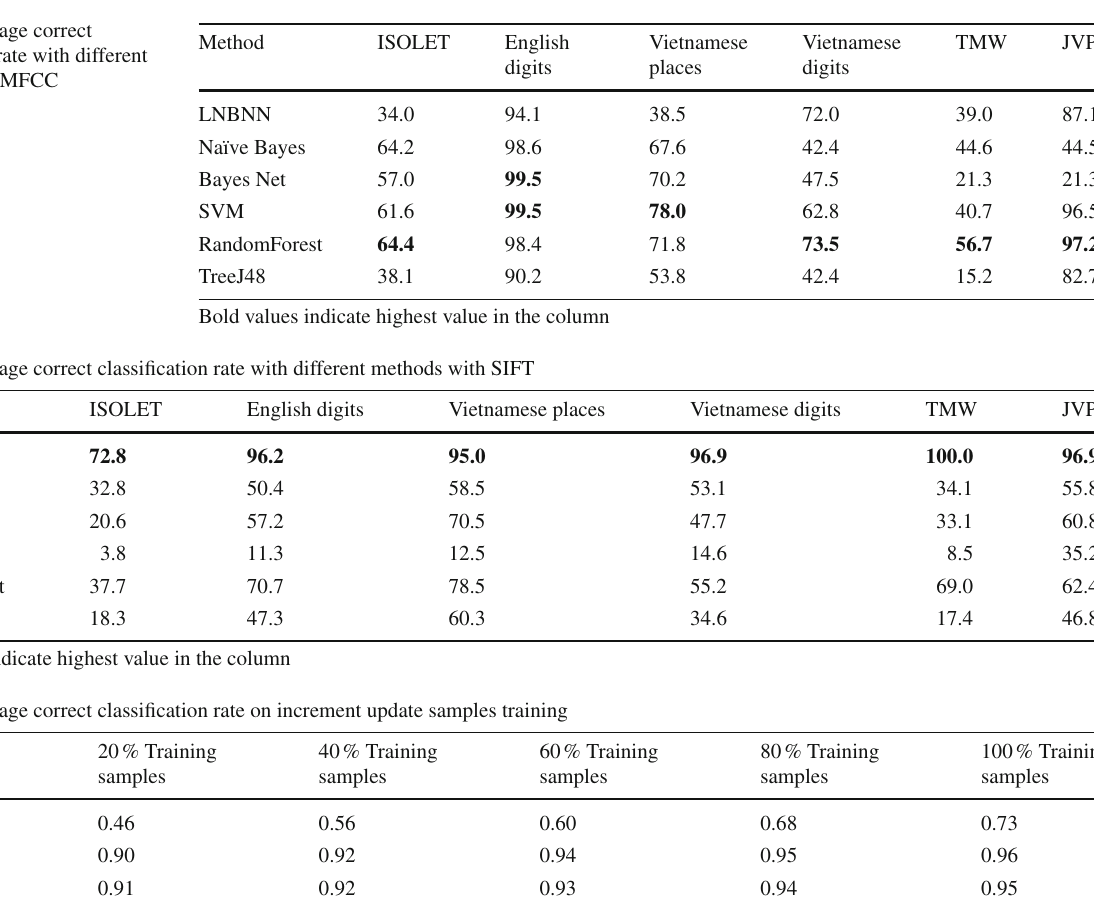
Table 2 Average correct classification rate with different methods with MFCC